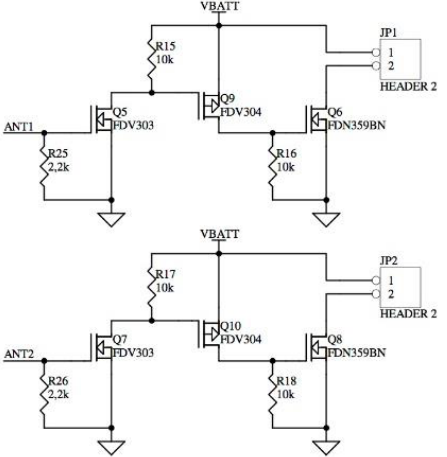
Figure 10. Antenna deployment system (electrical scheme) .